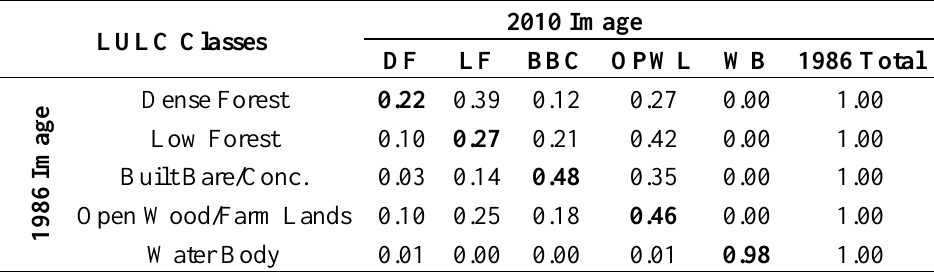
Table 5. Land use transition probability matrix from 1986 to